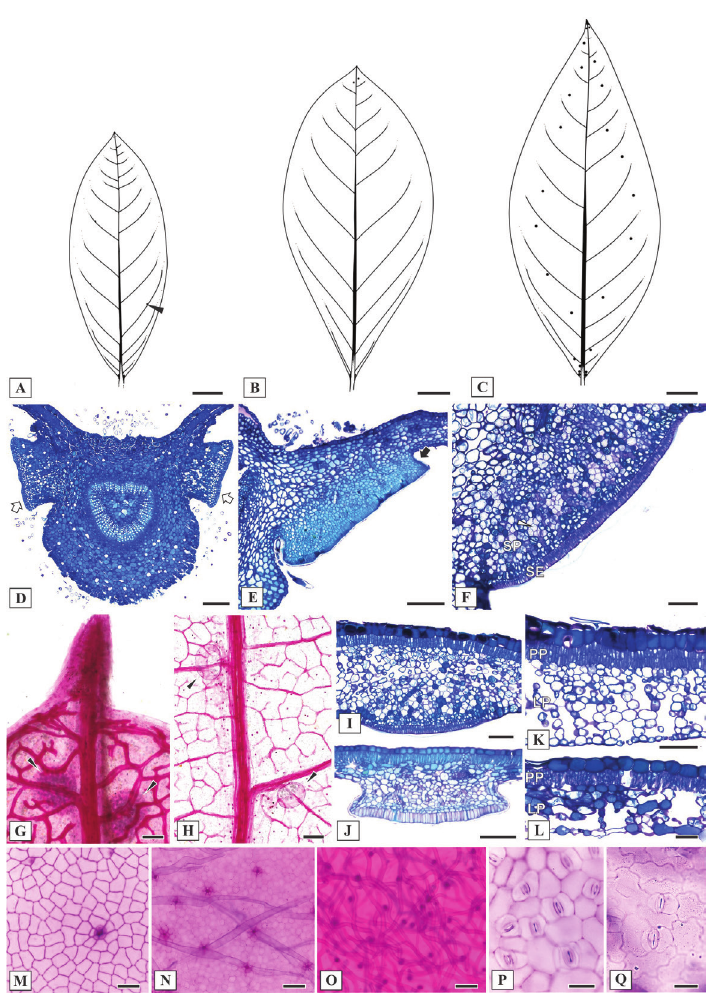
Figure 3. Leaf morphoanatomy of Mcvaughia species. A patterns of leaf glands distribution on the abaxial leaf surface of M. bahiana B patterns of leaf glands distribution on the abaxial leaf surface of M. piauhiensis C patterns of leaf glands distribution on the abaxial leaf surface of M. sergipana D transverse section of leaf base showing the basilaminar pair of stalked glands (white arrows) E basilaminar leaf gland with a stalk (black arrow) in M. piauhiensis F basilaminar gland in M. sergipana showing a sessile position (SE= anatomical arrangement with secretory epidermis, SP= vascularized secretory parenchyma) G–H laminar glands on the apex of cleared leaves of M. sergipana and M. bahiana respectively, note the apical tooth ( G ) I sessile laminar glands in M. sergipana J stalked laminar gland in M. piauhiensis K–L transverse sections of the leaf blade; mesophyll with uniserial palisade-like parenchyma and spongy parenchyma composed by several or few layers in M. sergipana and M. bahiana , respectively; note the idioblast with druse crystals at the mesophyll (white arrow) and the stomata distribution at the abaxial leaf surface (black arrow) M–N adaxial epidermis surface of M. piauhiensis and M. sergipana , showing scars of malpighiaceous trichomes O abaxial epidermis surface of trichomes abundance in M. bahiana P–Q outline of the anticlinal epidermal cell walls: straight in M. sergipana ( P ) and sinuous in M. bahiana ( Q ). Laminar scale bars: 1 cm ( A–C ), 100 μm ( D, F–K, N–O ), 150 μm ( E ), 50 μm ( L–M, P–Q